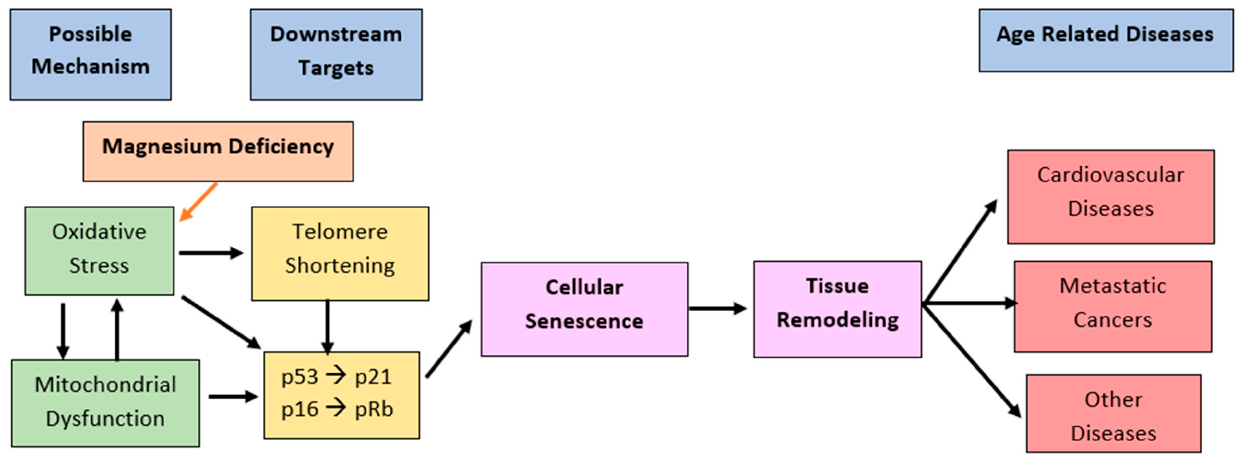
Figure 6. Impact of magnesium deficient states on telomerase activity [48].